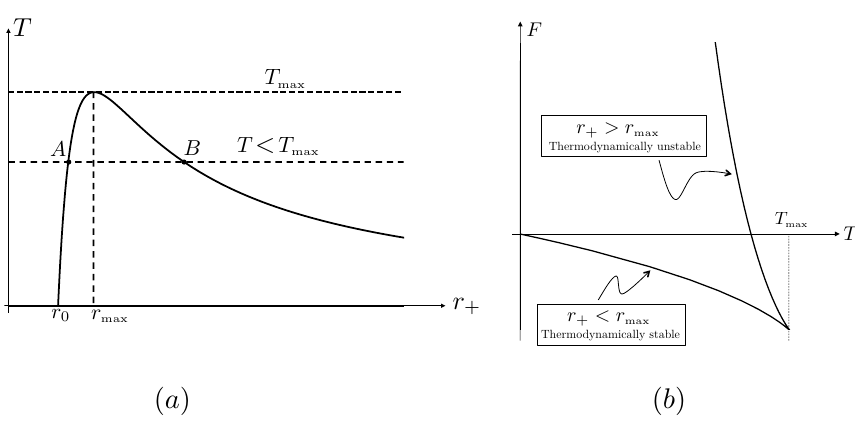
Figure 1 . Figure (a) is a graph of the temperature of the black hole solution as a function of the horizon radius r + in the case of vanishing cosmological constant (cid:3) = 0. The solution with r + = r 0 is the smallest possible black hole, it corresponds to the vacuum solution M = 0, and has T = 0. For T 2 [0 ; T ] there are two possible black holes, namely points A and B depicted in the (cid:12)gure, max but only the one with smallest radius is thermodynamically stable. For T > T hole solutions. Figure (b) is a graph of the Helmholtz free energy F as a function of T , clearly showing the unstable region versus the stable